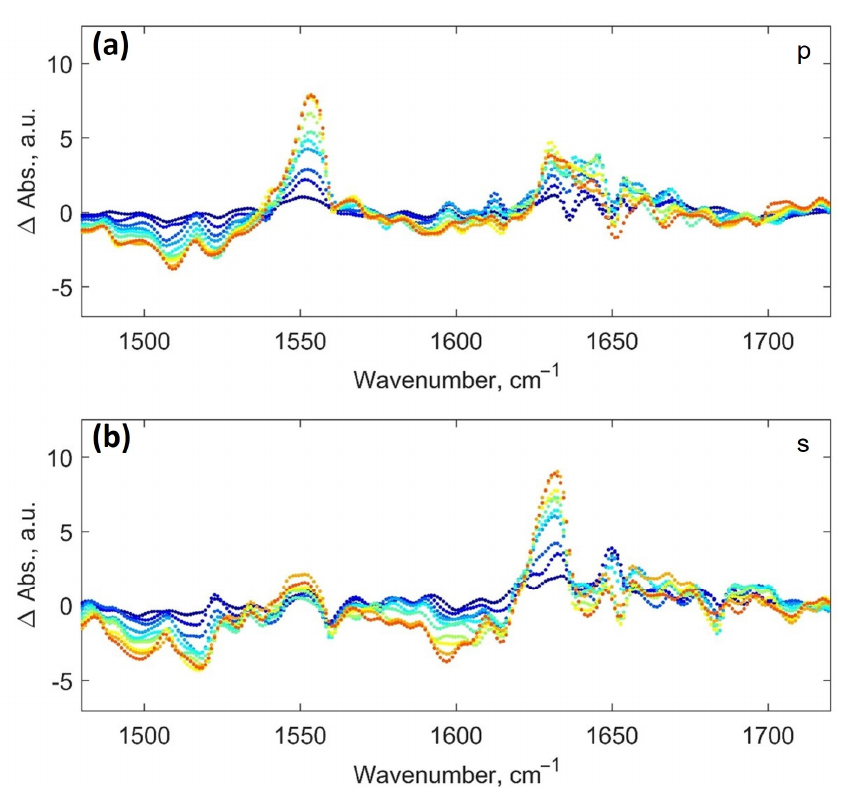
Figure 6. Difference between spectra recorded during Lys adsorption into the PEM during the time interval between 70 and 90 min and the spectrum of Lys taken during adsorption of Lys into the PEM after around 65 min for p ( a ) and s ( b ) polarizations. The changes in color of the presented data from cold to warm reflect the direction of the time span. Each of the spectra is obtained from sampling five spectra to decrease the noise. Time intervals between the presented spectra are around 2.37